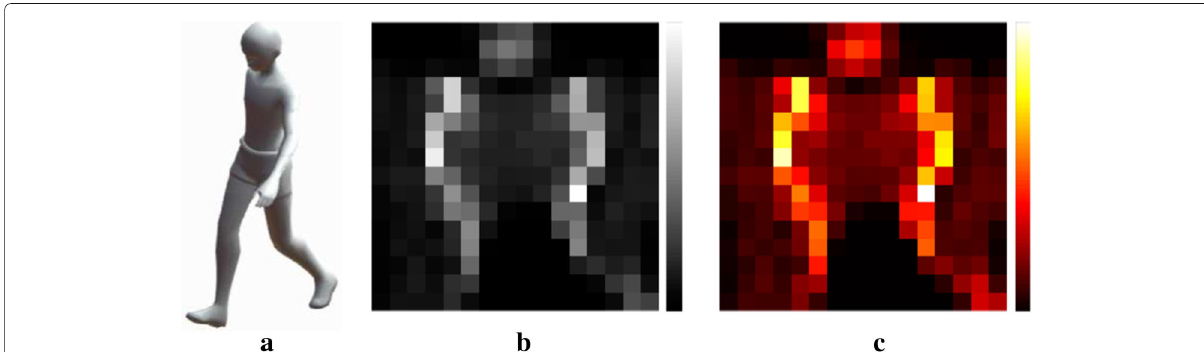
Fig. 4 Example of 2D histogram estimated by fitting a cylinder onto a 3D point cloud: a posture, b grayscale histogram, and c pseudo-color histogram for better visualization. The size of this histogram is 16 × 16